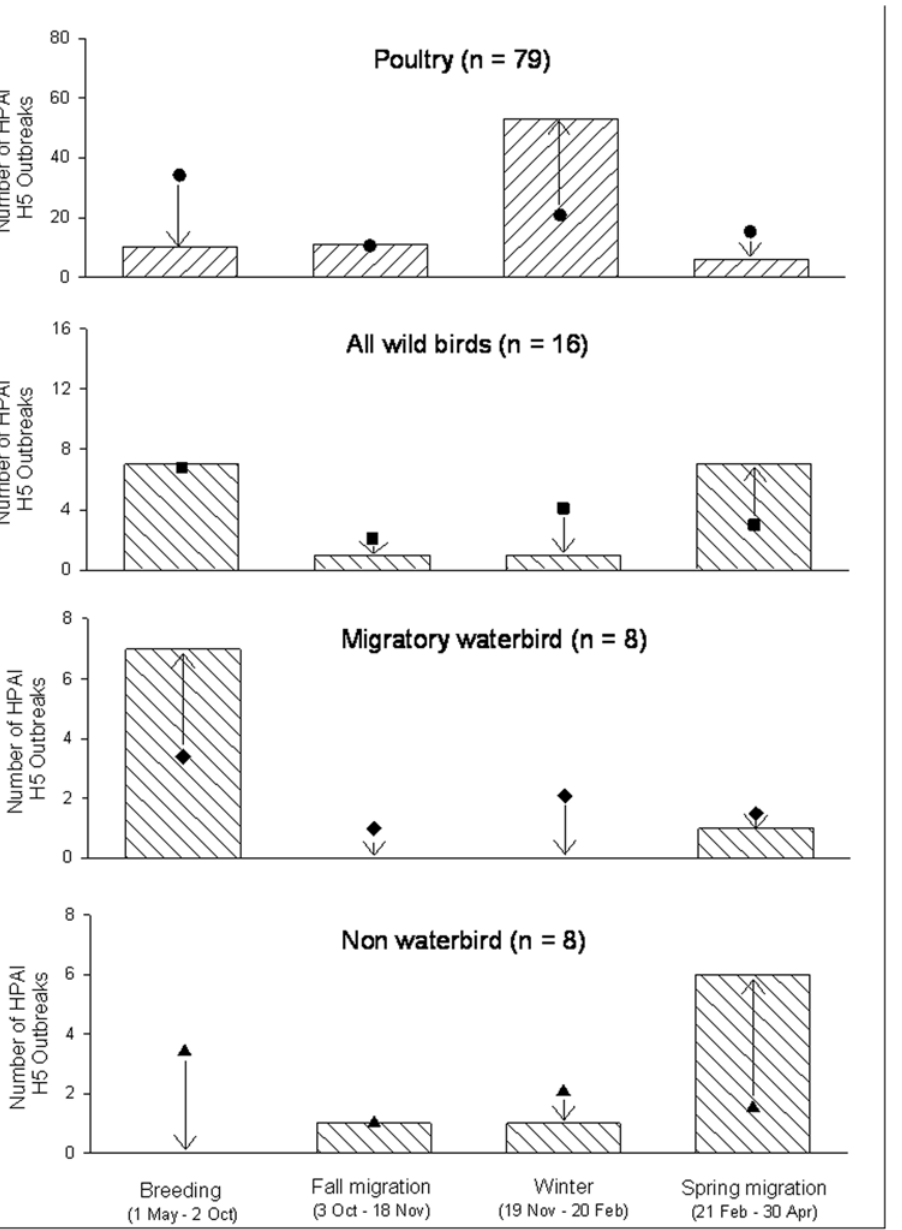
Figure 4. Frequency of poultry and wild bird H5N1 outbreak events in relation to season as determined by whooper swan annual cycle stage. Circles, squares, diamonds, and triangles represent the expected number of outbreaks in each of bird sector, bars represent the actual number of outbreaks, and arrows up/down indicate if there were greater than or less than expected numbers of outbreaks, respectively.